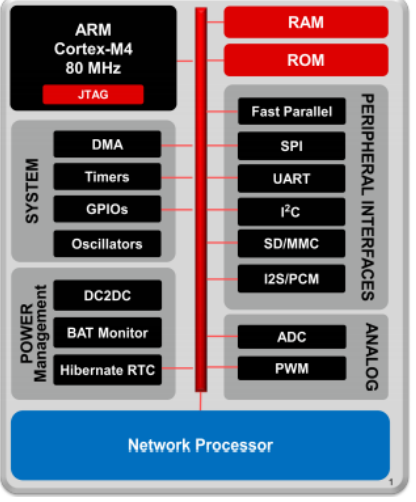
Figure 2. Hardware overview of